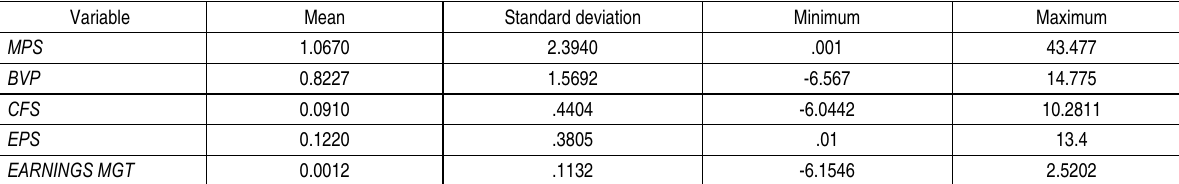
Table 2. Descriptive statistics for the sample